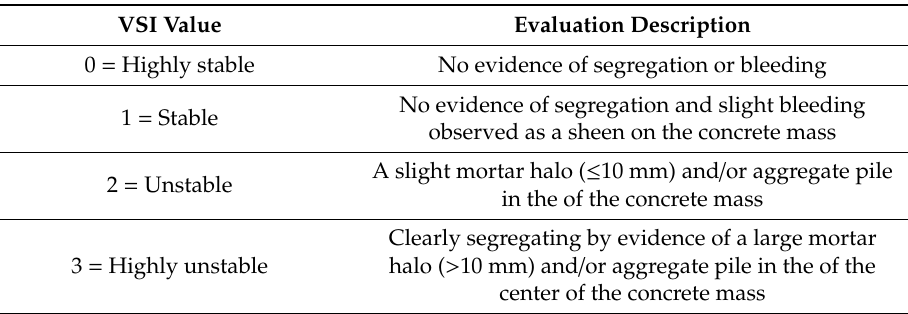
Table 11. Visual stability index (VSI) values for